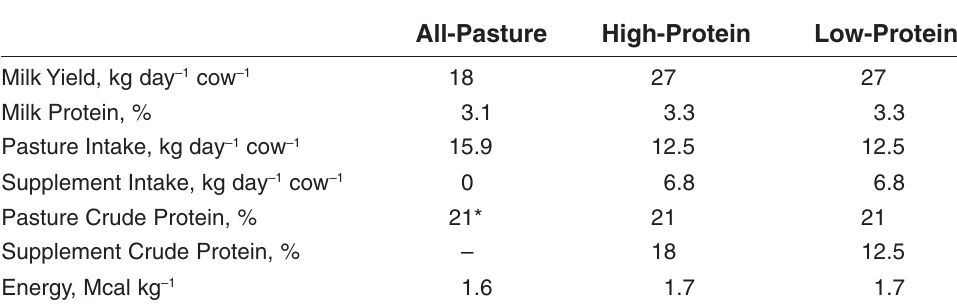
Summary of Assumptions for All-Pasture, High-Protein, and Low-Protein Feed Scenarios Developed with the CNCPS Model All-Pasture